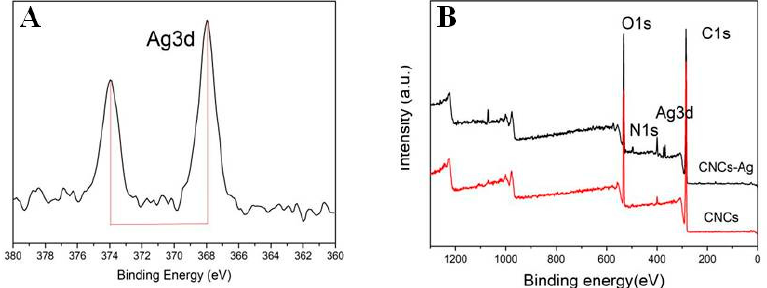
Figure 2. X-ray photoelectron spectroscopy (XPS) analysis of CNCs-Ag composite: Binding energy of Ag3d ( A ); binding energy of CNCs-Ag and CNCs ( B ).